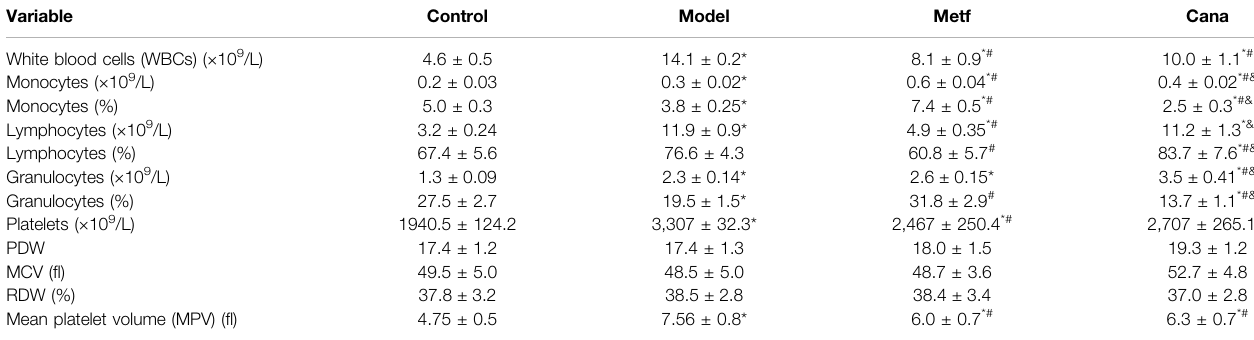
TABLE 1 | Effect of the canagli fl ozin (Cana) treatment on hematological parameters.